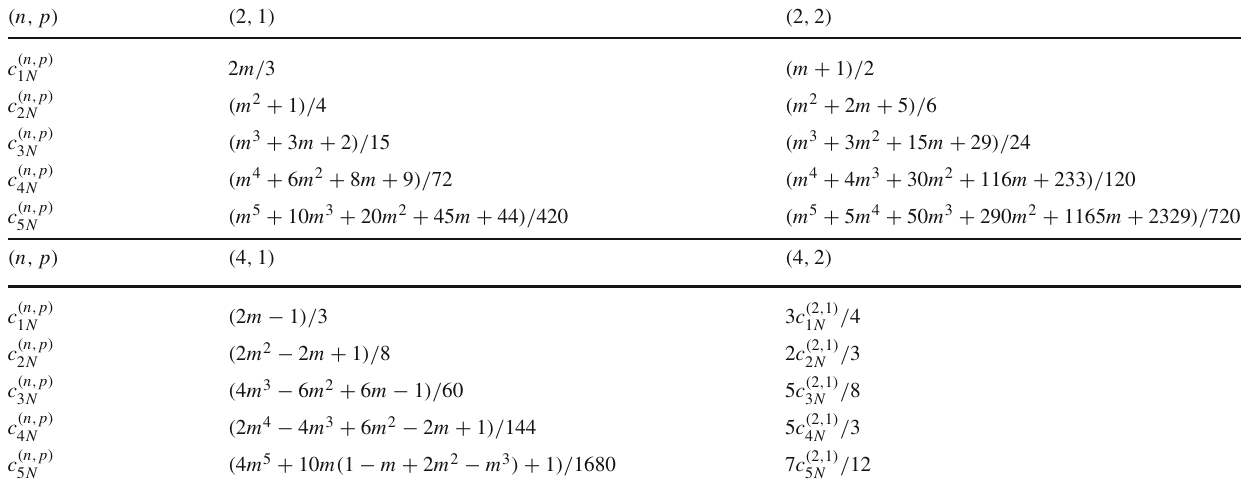
( n , p ) in Eq. (4.25) for ( n , p ) = ( 2 , 1 ),( 2 , 2 ),( 4 , 1 ) and ( 4 , 2 jN